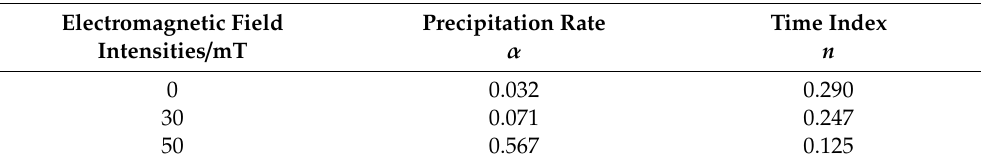
Figure 10. The relationship between ln[ − ln (1 − V δ / V S, δ )] and ln t. Table 10. Kinetic parameters of the δ phase precipitation in the EMS-LSFed Inconel 718 superalloy samples prepared with di ff erent electromagnetic field